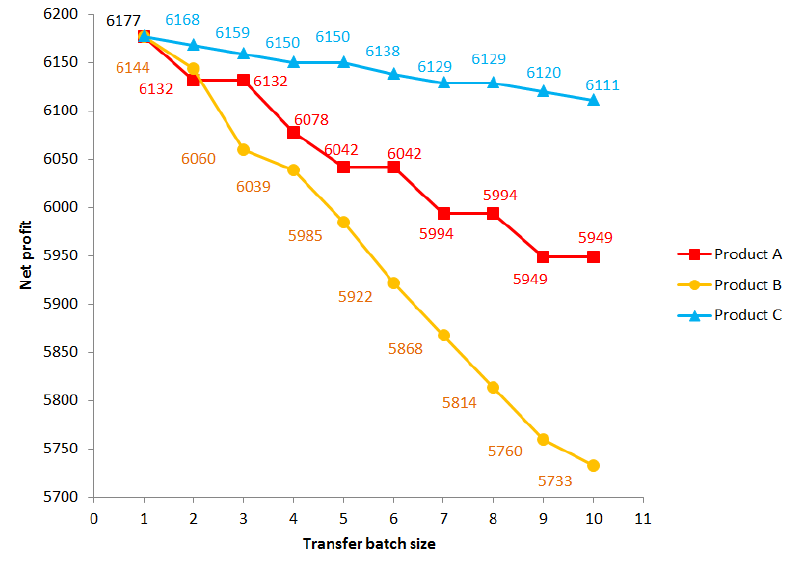
Fig. 6. E ff ect of transfer batch size in net